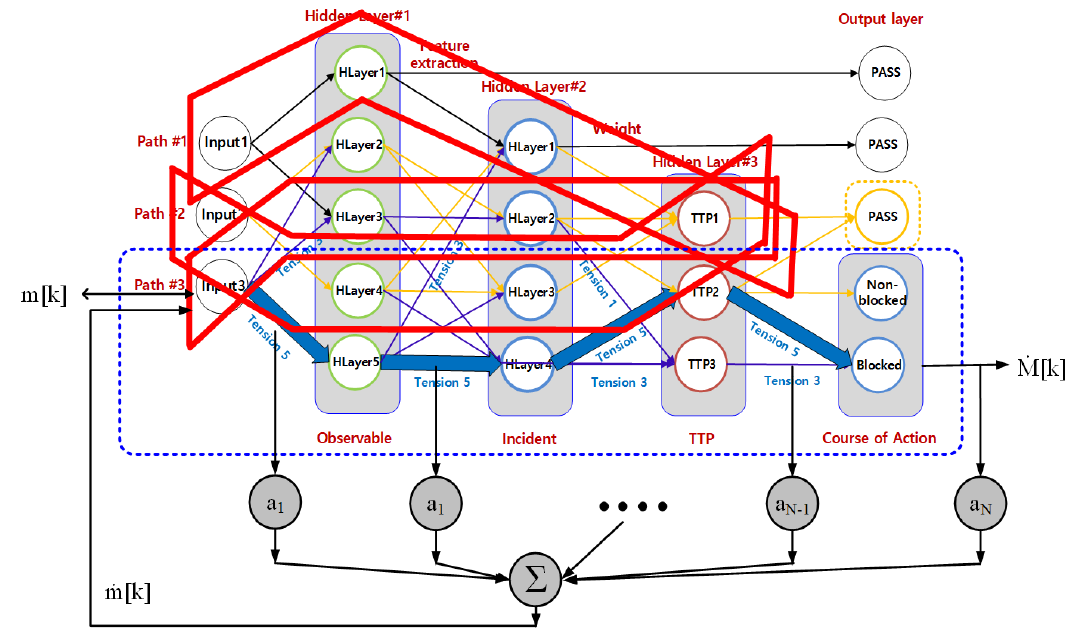
Figure 3. Layer processing with multiple hash chains.